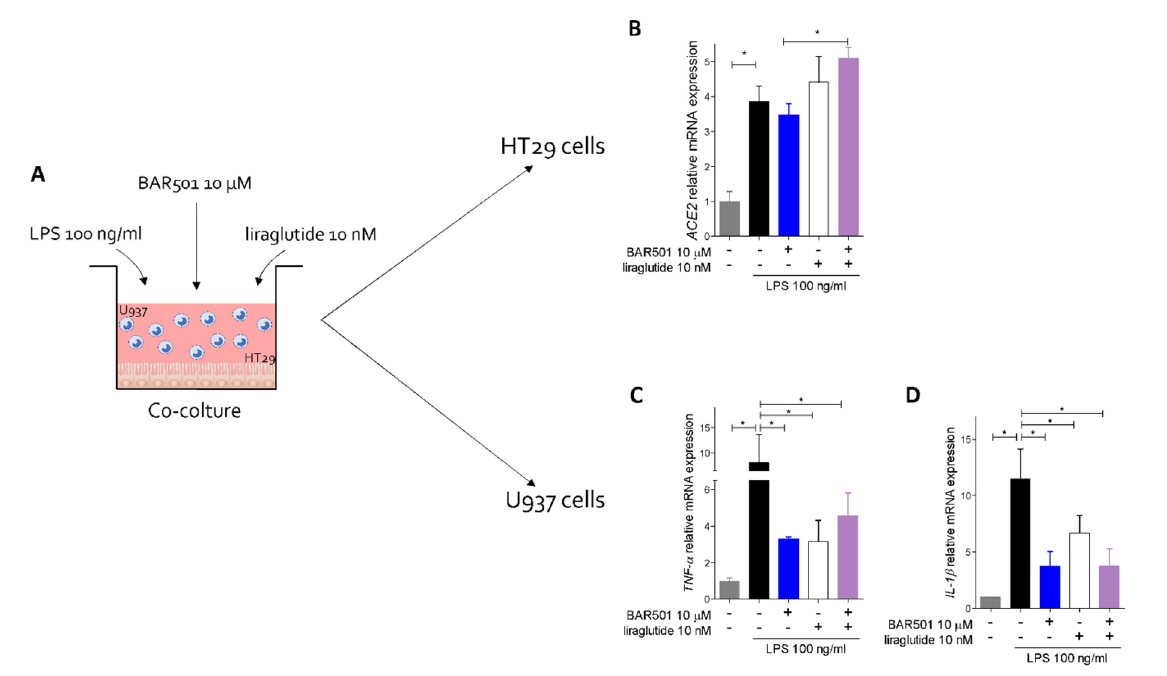
Figure 9. Regulation of ACE2 and inflammation by GPBAR1 agonism in colon epithelial cells and macrophages co-coltures. ( A ) HT29 and U937 cells were used to perform a coculture experiment, as described in Materials and Methods Section. ( B ) Relative mRNA expression levels of ACE2 gene in HT29 cells; relative mRNA expression levels of cytokines ( C ) IL-1 β and ( D ) TNF- α in U937 cells. The data are normalized to GAPDH mRNA. Results are expressed as mean ± SEM; * p < 0.05.